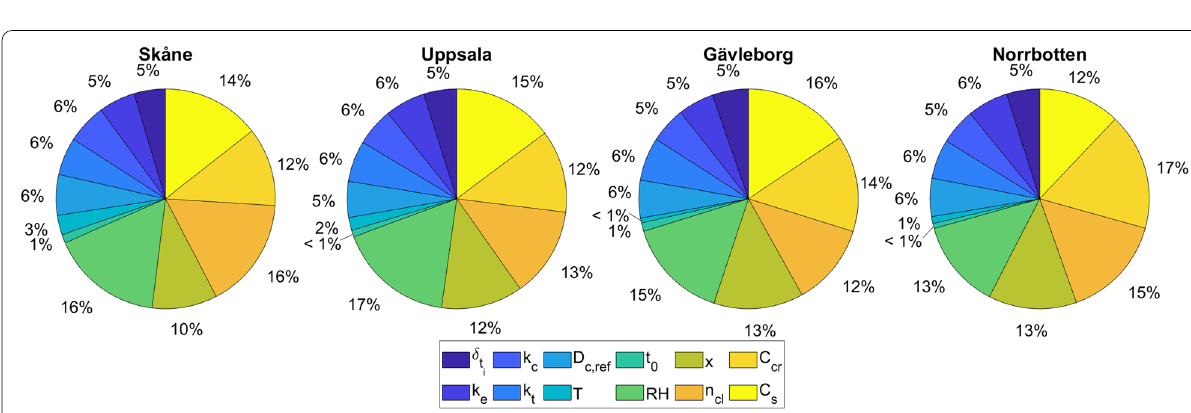
20% while a 20% decrease causes a decrease in the vicin- ity of -20% in the mean value of the end-of-century cor- rosion rate. A 20% increase and decrease in the mean annual average temperature in Skåne causes changes of 12% or -11%, respectively, in the mean value of the + corrosion rate. Changes in the parameters δ t i , t 0 , k e , k c , k t , and D c , ref have similar effects to those on the probability of corrosion initiation. The sensitivity of the mean value of the end-of-century corrosion rate to the different input parameters is summarized in Fig. 13. This sensitivity is assessed based on the average absolute slope of the lines in Fig. 12 in the range of -1% – 1% change in the mean value of each parameter.